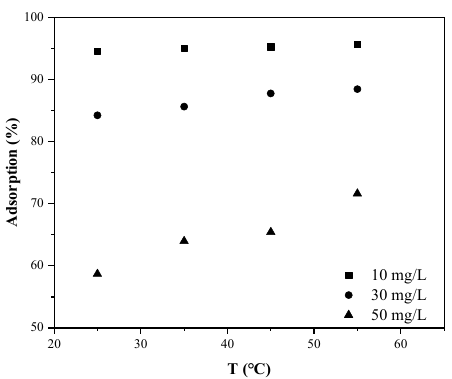
Figure 11. Influence of temperature on MB removal efficiency by SLS-C (adsorbent dosage S/L = 0.15 g·L − 1 , pH = 5.0, contact time = 120 min).